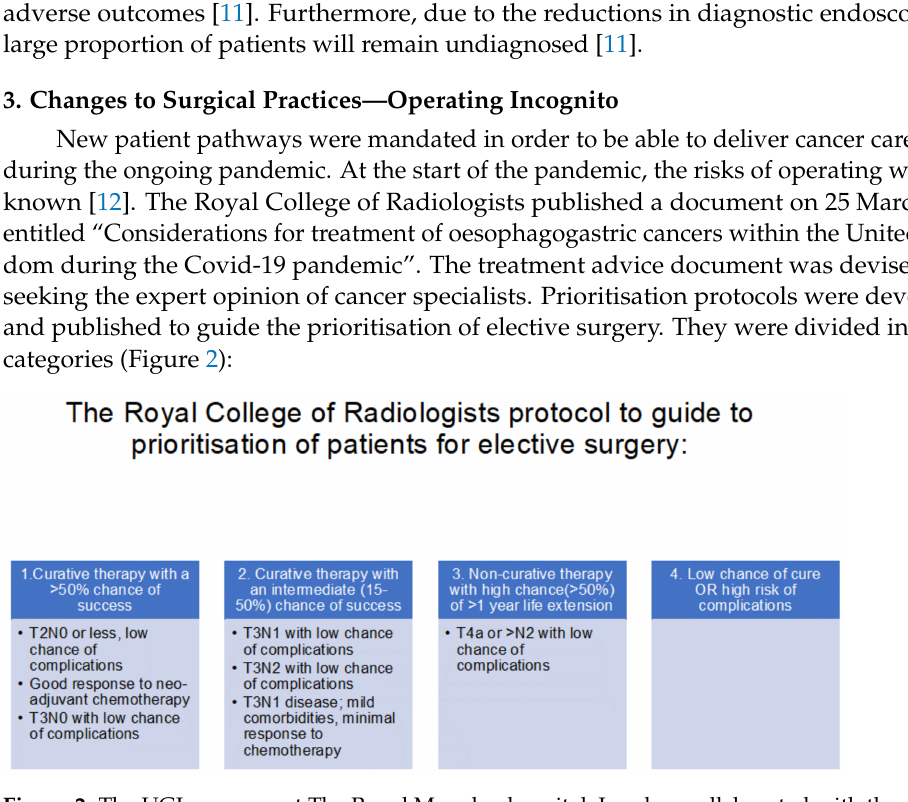
Figure 2. The UGI surgeons at The Royal Marsden hospital, London, collaborated with the Associa- tion of Upper Gastrointestinal Surgeons (AUGIS) and NHS England Specialty Guide for Cancer and Coronavirus and devised a way of clinically prioritising patients for UGI surgery. This framework allowed surgery to continue and was further refined as they became the West London specialist surgery “cancer hub”. They focused on effective triage, via the discussion of each case at specialist UGI multidisciplinary team meetings (sMDT) to personalise treatment plans according to clinical state, disease stage and whether alternative treatments were possible. Surgical cases were triaged according to clinical